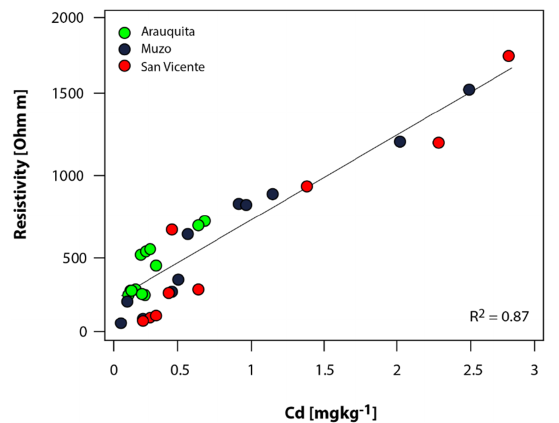
Figure 7. Correlation between resistivity determinations and Cd concentrations obtained by the 2D-ERT and inductively coupled plasma optical emission spectrometry (ICP-OES) techniques, respectively. The coefficient of determination was high for the data collected in this survey of 27 farms. The municipality of Arauquita (green) shows the lowest resistivity and cadmium levels (below 1000 Ohm·m and 0.62 mg · kg − 1 Cd, respectively). The municipality of San Vicente de Chucurí (red) shows the highest resistivity and cadmium values in the soil (1815 Ohm·m and 2.76 mg · kg − 1 Cd, respectively). The municipality of Muzo (blue) shows the second highest values.